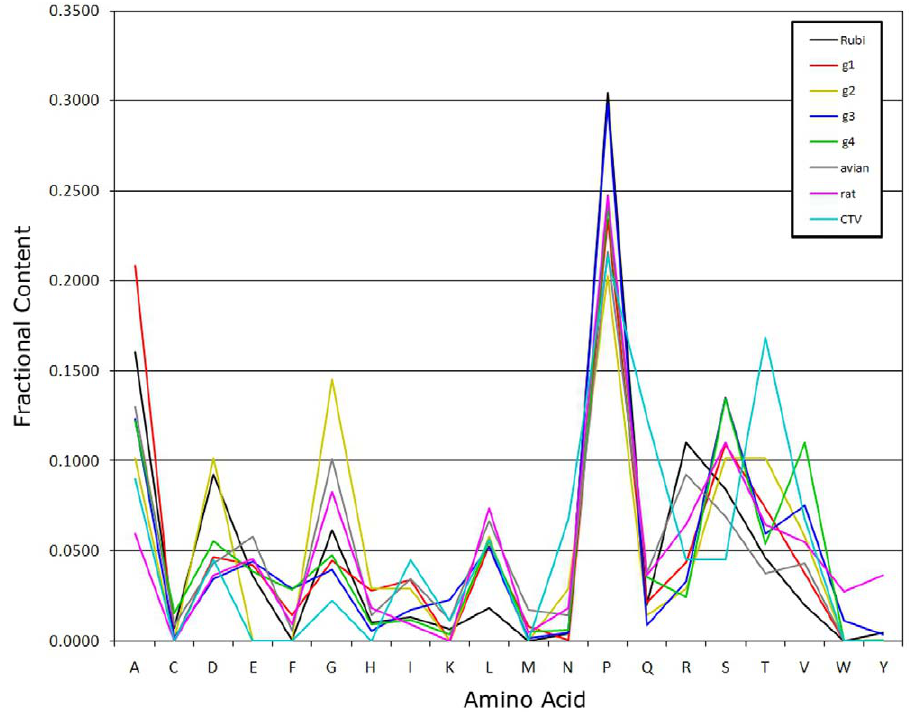
Figure 5. Proportion of aa in the PPR IDR of rubi-like viruses.